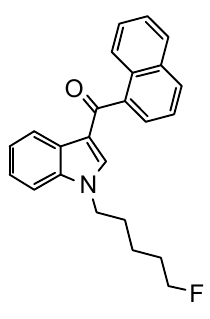
Figure 1. Chemical structure of AM-2201.